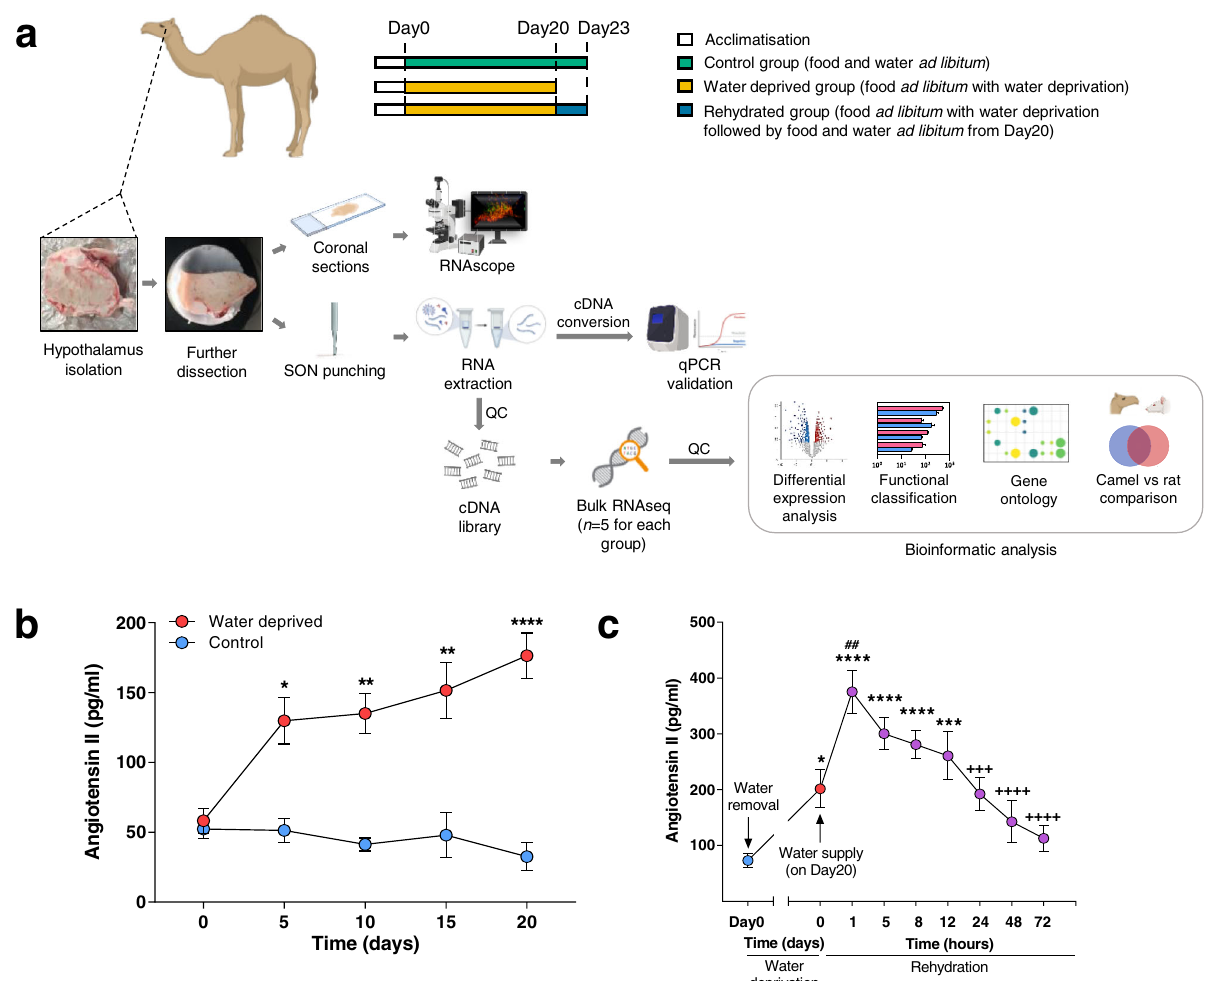
Fig. 1 Experimental groups and change of plasma angiotensin II level. a Experimental work fl ow studying the camel SON (created using BioRender.com incorporating original material by the fi rst author). After acclimatisation, hypothalamic samples were collected from 19 camels divided into 3 groups; control (water ad libitum , n = 5), WD (water deprivation for 20 days, n = 8) and rehydrated (water deprivation for 20 days followed by water ad libitum for three days, n = 6). A tissue block containing the SON was collected from the camel brain and further dissected to facilitate slicing. Coronal hypothalamic sections were prepared for RNAscope or collection of the SON samples ( n = 5 for each condition) for RNAseq and/or qRT-PCR. For RNAseq, the population of RNA molecules were converted to cDNA for the next generation sequencing work fl ow. RNAseq data were analysed using software packages or online databases for quality control (QC), differential expression analysis, functional classi fi cation, and gene ontology analysis. The camel SON differentially expressed genes (DEGs) were compared to rat SON DEGs. Plasma ANG II levels during WD and following recovery by rehydration were measured. b Plasma ANG II over 20 days of WD compared to control. Data were analysed using two-way repeated measures ANOVA with Š ídák ’ s multiple comparisons test. *padj ≤ 0.05, **padj ≤ 0.01, ****padj ≤ 0.0001 in relation to control. c Plasma ANG II over 72 h of rehydration (purple dots) for the rehydration camels ( n = 6) in comparison to their control state (Day0, blue dot) and after 20 days of WD (Day20, red dot). Data were analysed using one-way mixed-effects model (restricted maximum likelihood) for repeated measures with Tukey ’ s multiple comparisons test. *padj ≤ 0.05, ***padj ≤ 0.001, ****padj ≤ 0.0001 in relation to control (Day0). ##padj ≤ 0.01 in relation to 20 days WD (Day20). +++ padj ≤ 0.001, +++ + padj ≤ 0.0001 in relation to 1 h levels of the VIP mRNA, a well-known suprachiasmatic nucleus Supplementary Data S2a. There were 21597 genes expressed in (SCN) marker gene 25 , in both rostral and caudal SONs con- fi rming the identity of the neuroendocrine cells collected as AVP and OXT MCNs (Supplementary Table S1). Transcriptome pro fi les of control and WD camel rostral SON . We sequenced the ribosomal depleted transcriptomes from the rostral SON of control ( n = 5) and WD ( n = 5) camels. Only RNA samples that passed stringent quality control (QC) checks (see Methods) were subject to RNAseq (Supplementary Data S1). A complete pro fi le of basally expressed (control) genes and differentially expressed genes (DEGs) are catalogued in